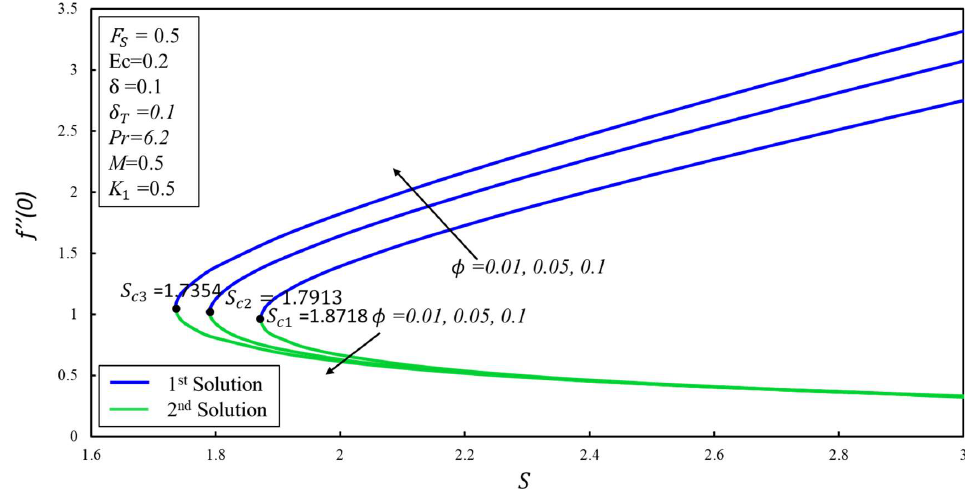
Figure 12. Changes of 𝑓′(𝜂) for 𝐹 (cid:3046) .